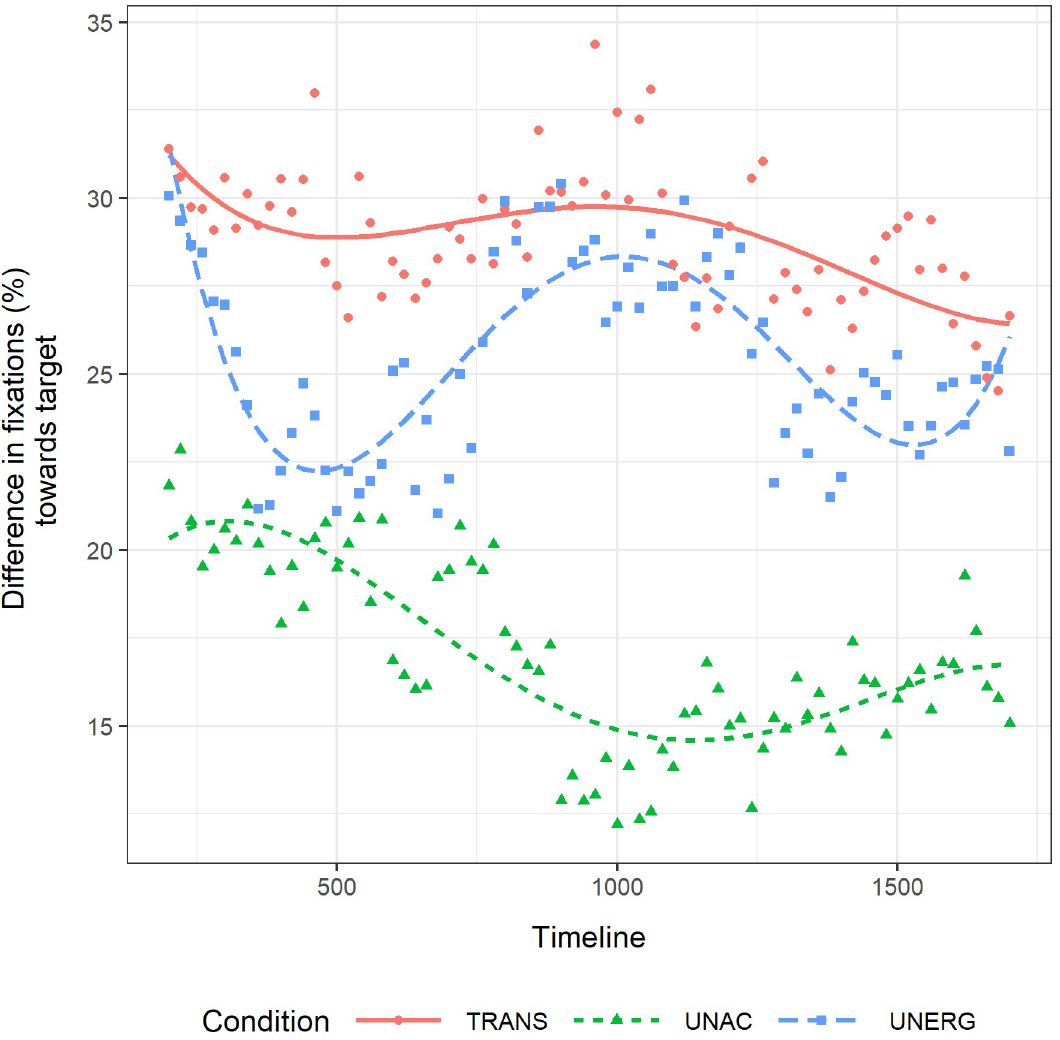
Fig 3. Difference of fixations to visual target in the post-verb frame. Difference of mean percentage of fixations to the visual target between test and control trials across the post-verb frame (from 200 ms until 1700 ms after verb offset). The timeline is centered in 0 ms, which corresponds to verb